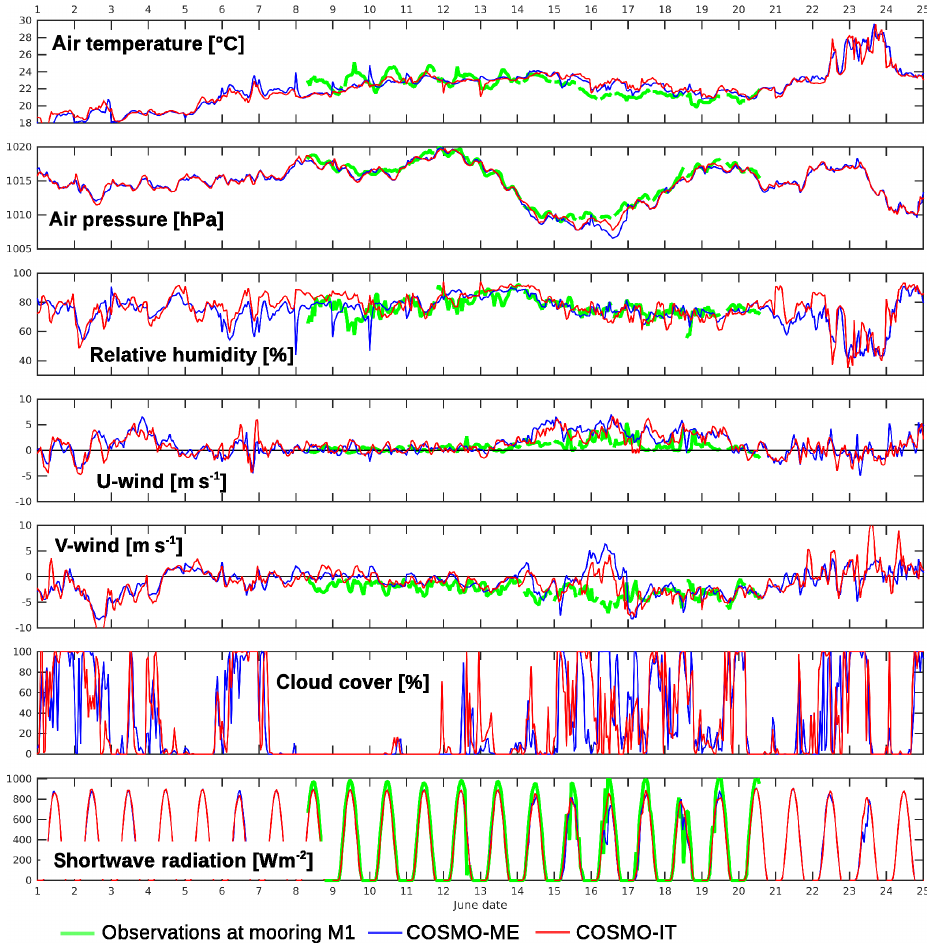
Figure 6. The time series of the measured and predicted atmospheric parameters at the site of mooring M1 from the observations of the mete- orological buoy on top of M1, COSMO-ME, and COSMO-IT. U -wind and V -wind denominate the zonal and meridional wind components, respectively. The cloud cover was not recorded at M1. The precipitation is not shown because no precipitation was predicted or measured during the entire